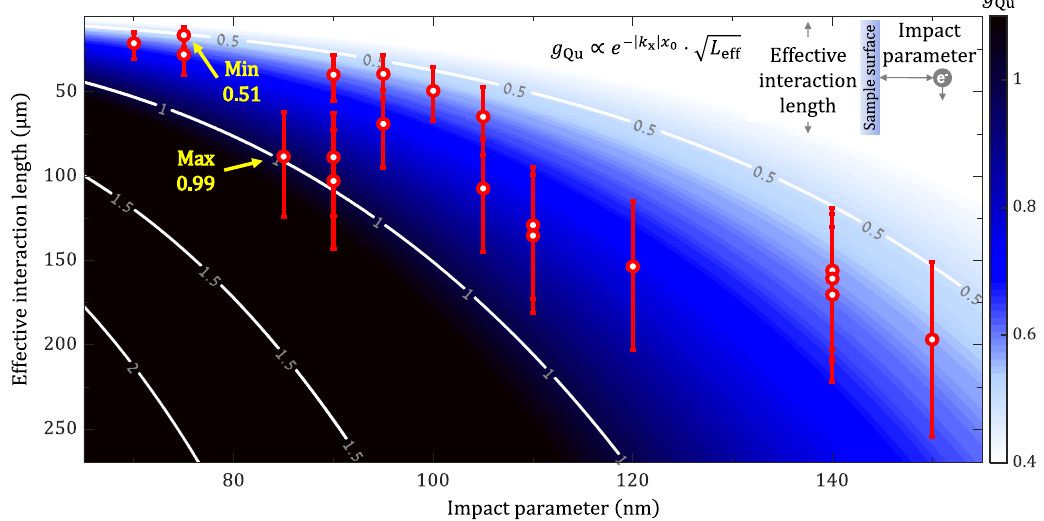
FIG. 5. Quantum coupling strength between free electrons and photonic quasiparticles. The quantum coupling strength is proportional ffiffiffiffiffiffiffiffi p ∝ e − j k x j x 0 · L to g and its values are extracted for 19 EELS measurements. Each value is overlaid on a theoretical calculation of the Qu eff quantum coupling (colored background), derived in Supplemental Material, Notes 1 and 5 [64]. The calculated g electron beam Gaussian spatial distribution (with a standard deviation of 30 nm; see Supplemental Material, Note 5 [64], for more details). The red error bars represent a 10-nm difference in the impact parameter. The horizontal error bar for all data points is 10 nm in width, stemming from the fit resolution of the impact parameter [Fig. 3(c)]. All the measurements in this figure are with 200-keV